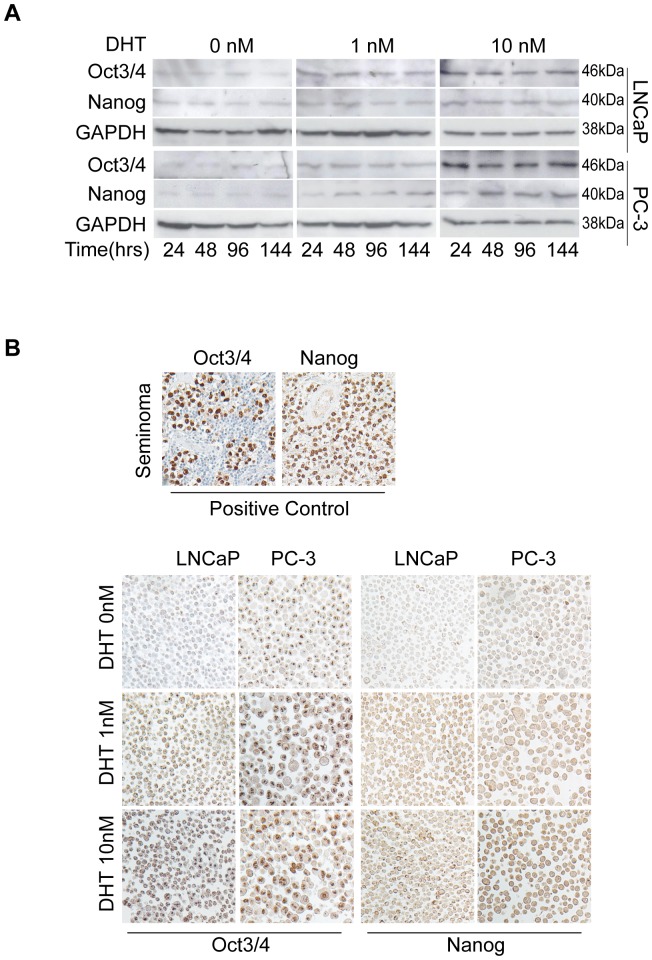
DHT increases Oct3/4 and Nanog expressions in prostate cancer cell lines.(A) The higher expressions of Oct3/4 and Nanog by immunoblotting assay are shown in LNCaP and PC-3 cells treated with 1 nM and 10 nM DHT treatments, respectively, for variable periods of times. (B) The immunocytochemical staining shows higher levels of these two factors in both cell lines treated with different concentrations of DHT. Human seminoma tissue sections were used as positive controls for these two antibodies (bar scale: 50 µm).